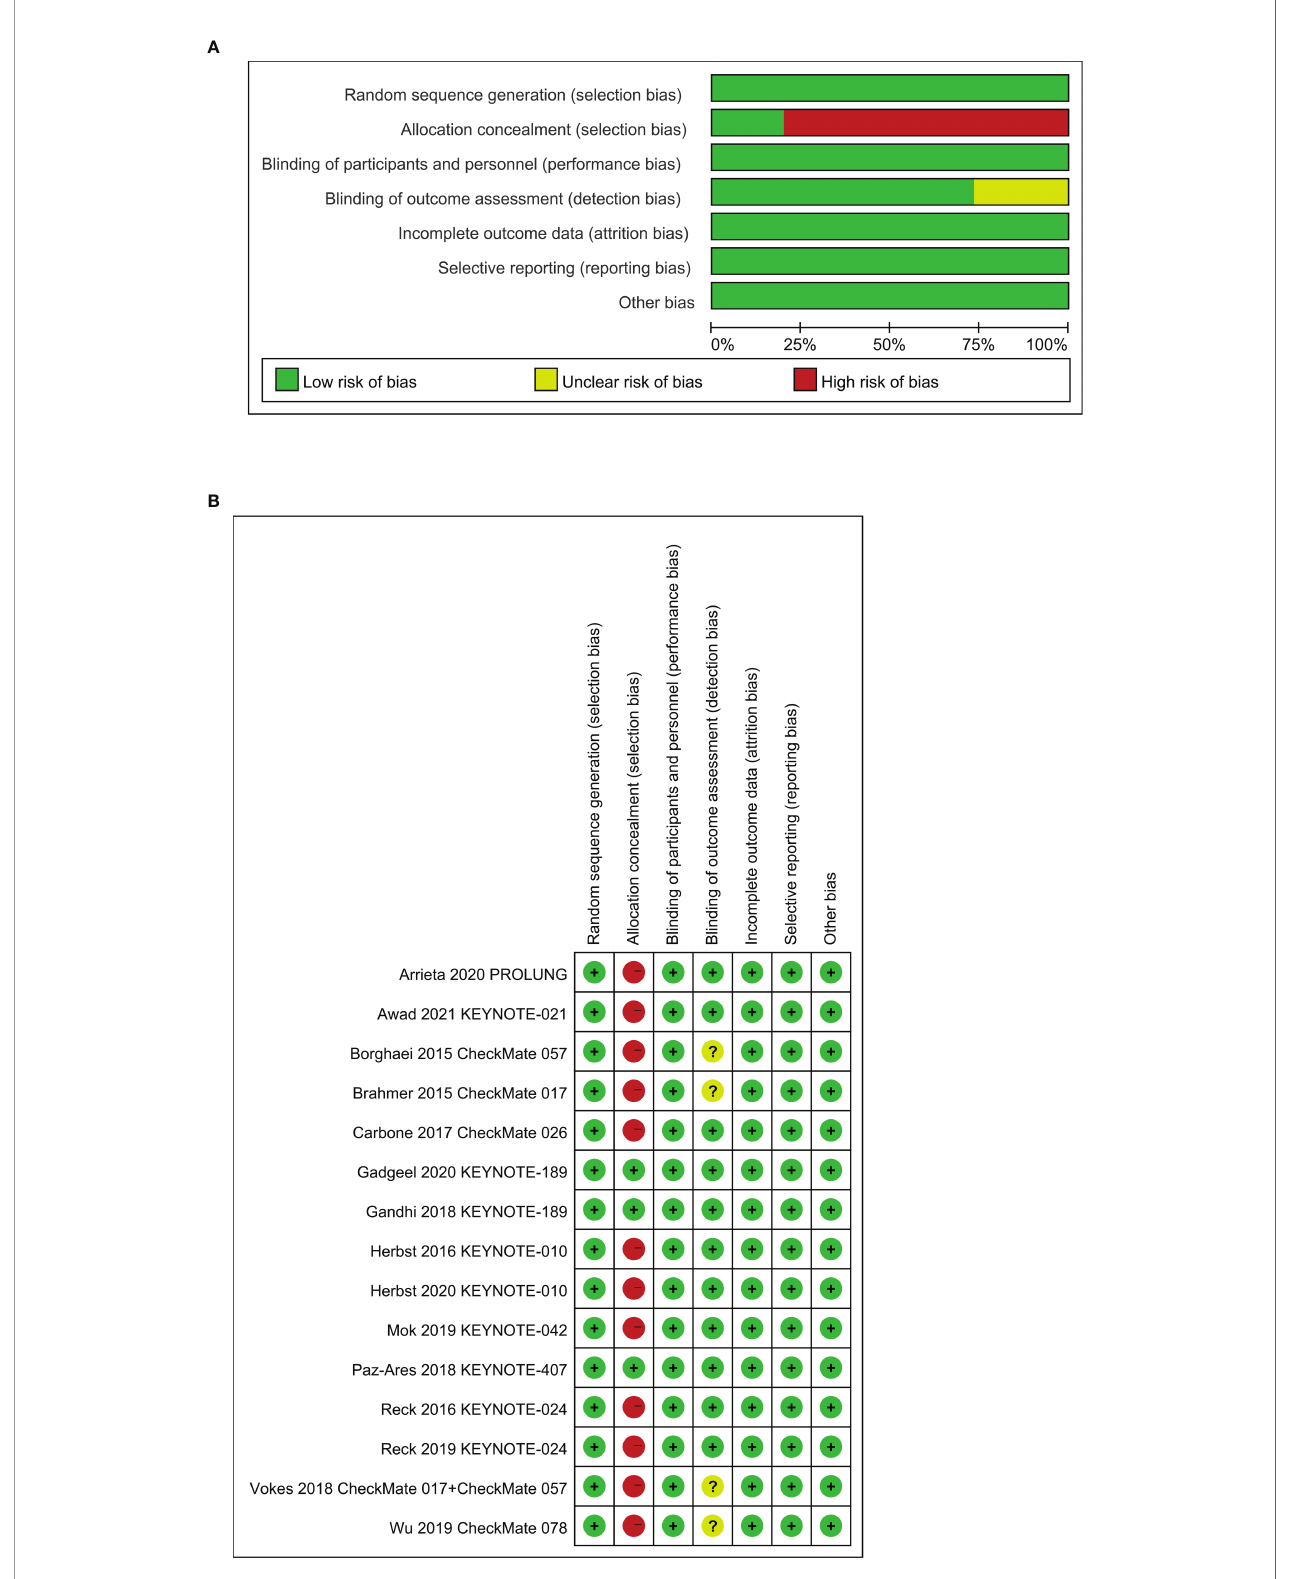
FIGURE 2 | Assessment of bias risk, (A) risk of bias graph, (B) risk of bias